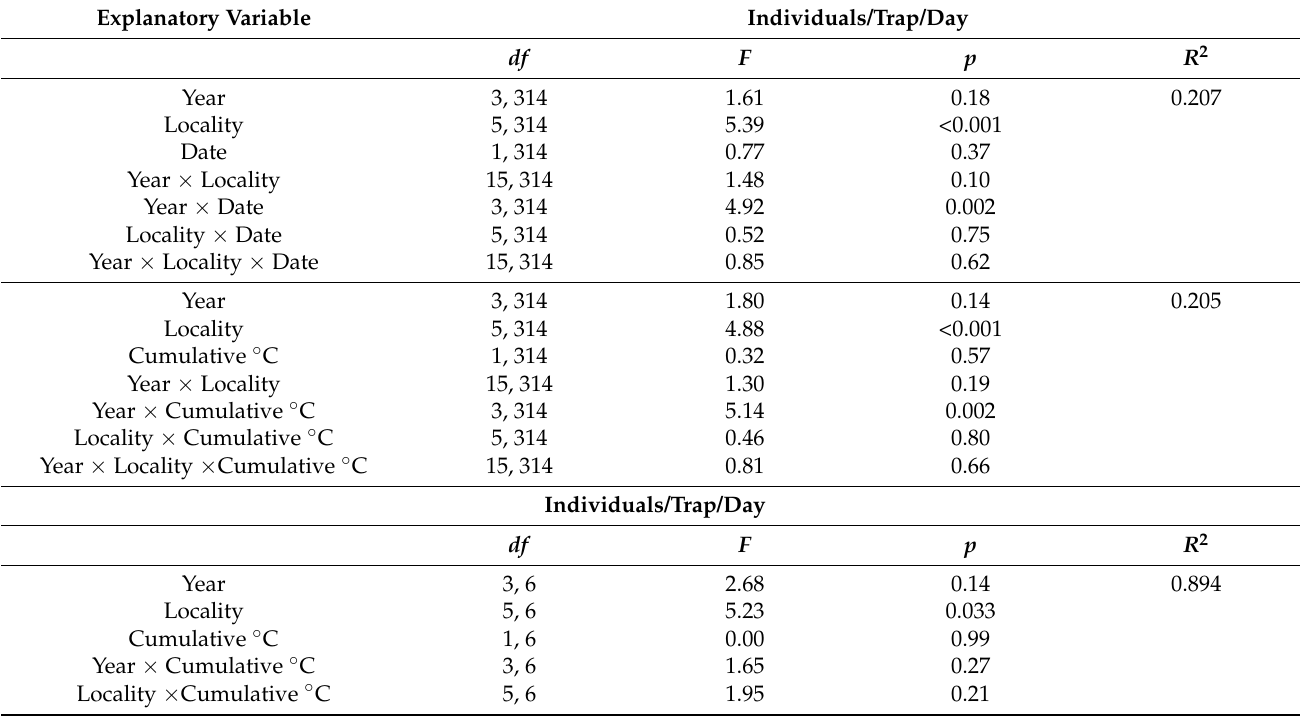
Table 3. Above, GLM results showing the effects of sampling date (or cumulative ◦ C) × year × locality on the number of CGW individuals per trap and day. Below, GLM results showing the effects of year × cumulative ◦ C + locality × cumulative ◦ C on the number of CGW individuals per trap and